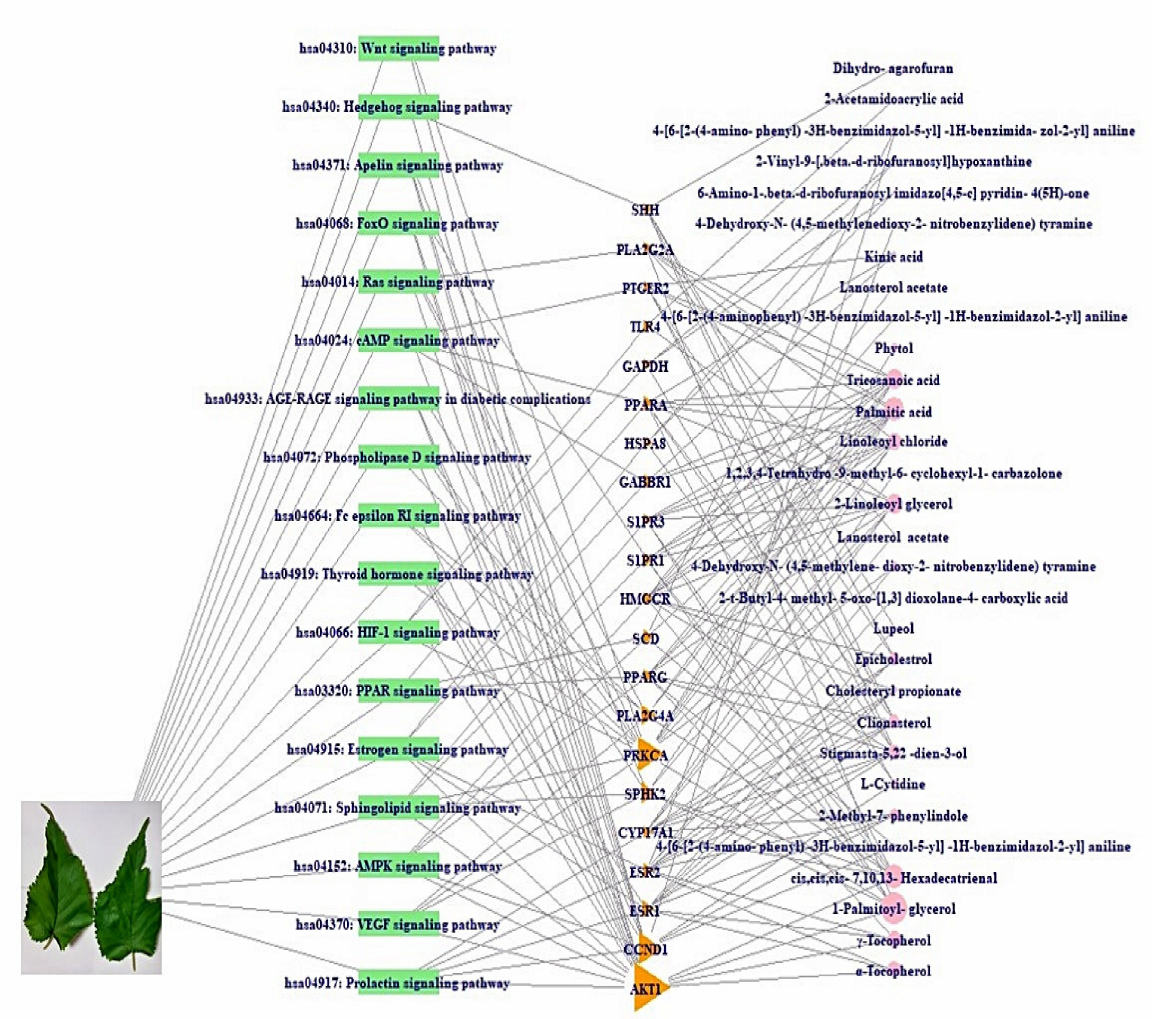
Figure 6. S-T-B networks of M. alba L.